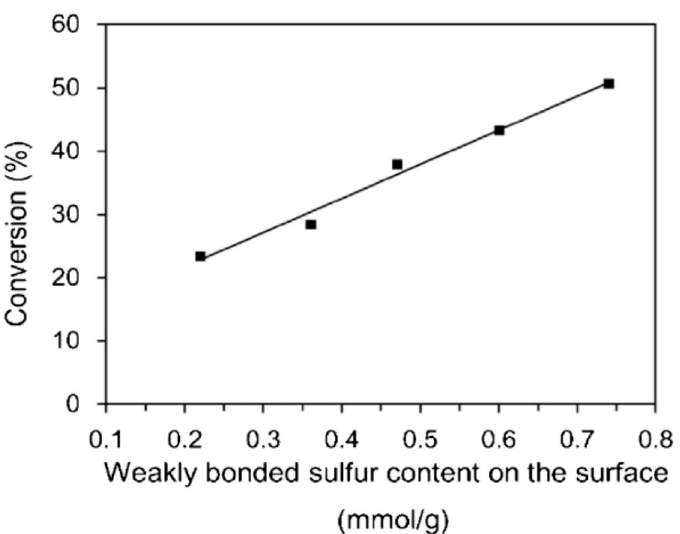
Figure 7. The relationship between the DBT conversion and weakly bonded S content of the catalyst. Yue et al. [154].